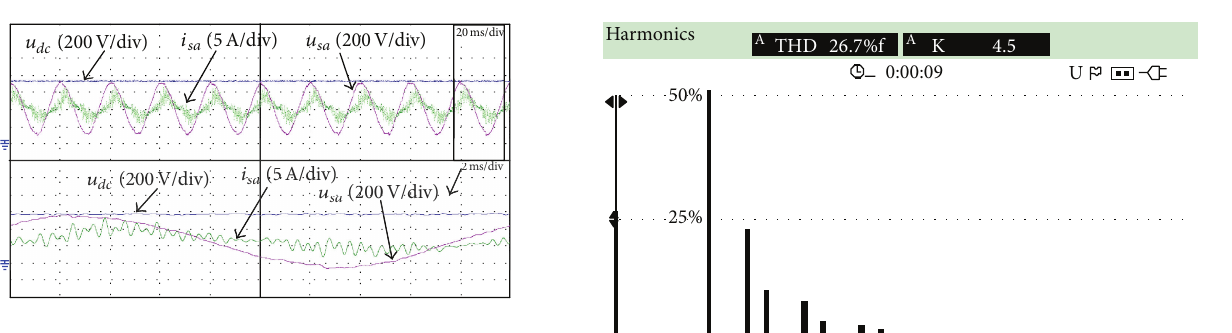
Figure 8: APF compensation current (nonload).